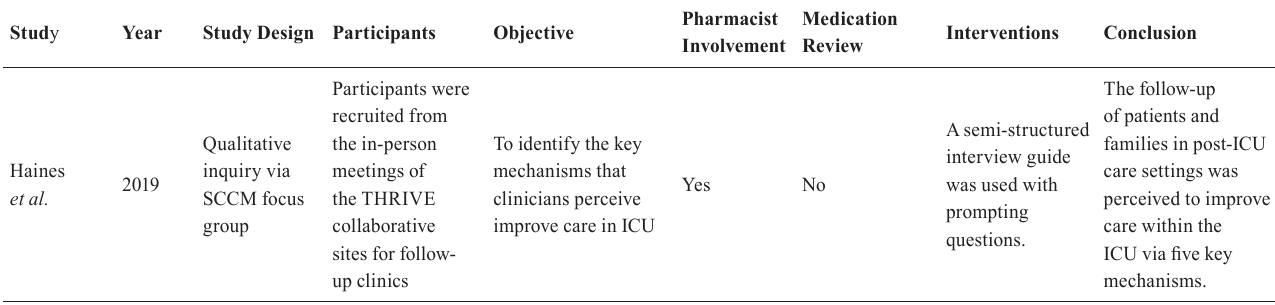
TABLE I - S ummary of the literature related to pharmacist contributions or medication review for post-ICU survivors